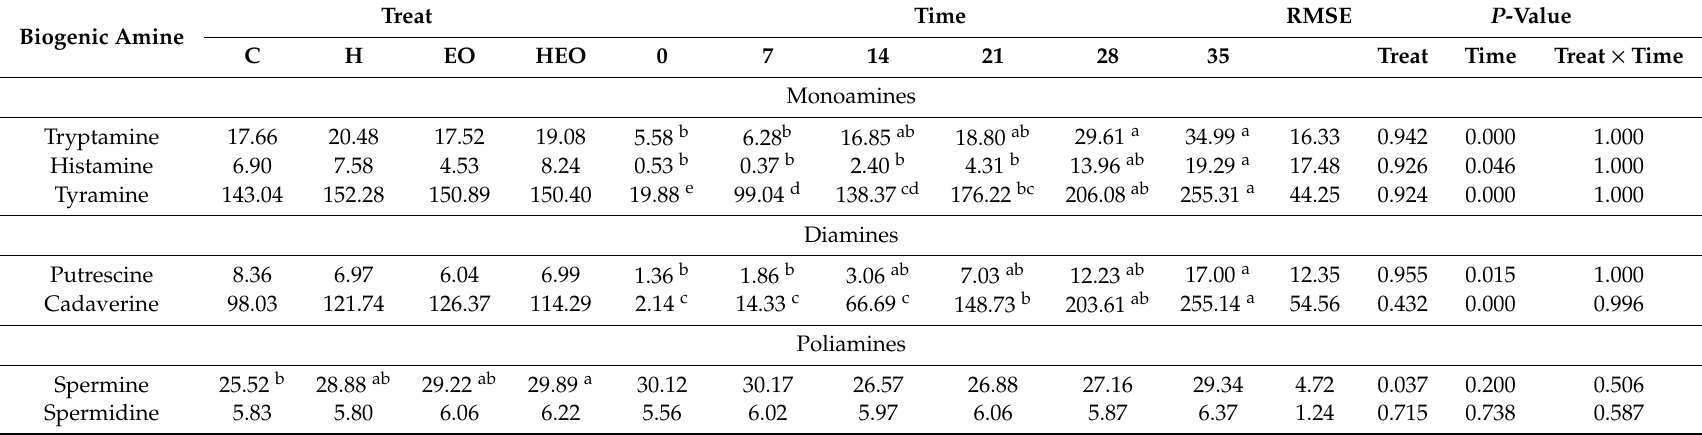
Table 1. Biogenic amine contents (mg / kg) in fresh sausages stored at 2 ◦ C under anaerobic modified atmosphere storage as a function of antimicrobial treatment (Treat) and storage day